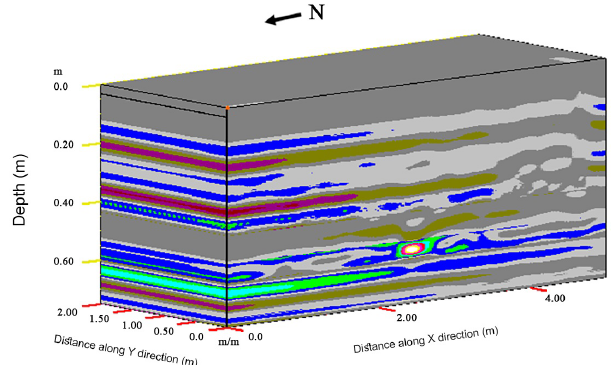
Figure 7. A 900MHz antenna radargram along Profile 9003. The white rectangle along the radargram at approximate depth of 0.20m may correspond to buried wall. The 4m wide depression at end of the profile may be correlated to buried channel.